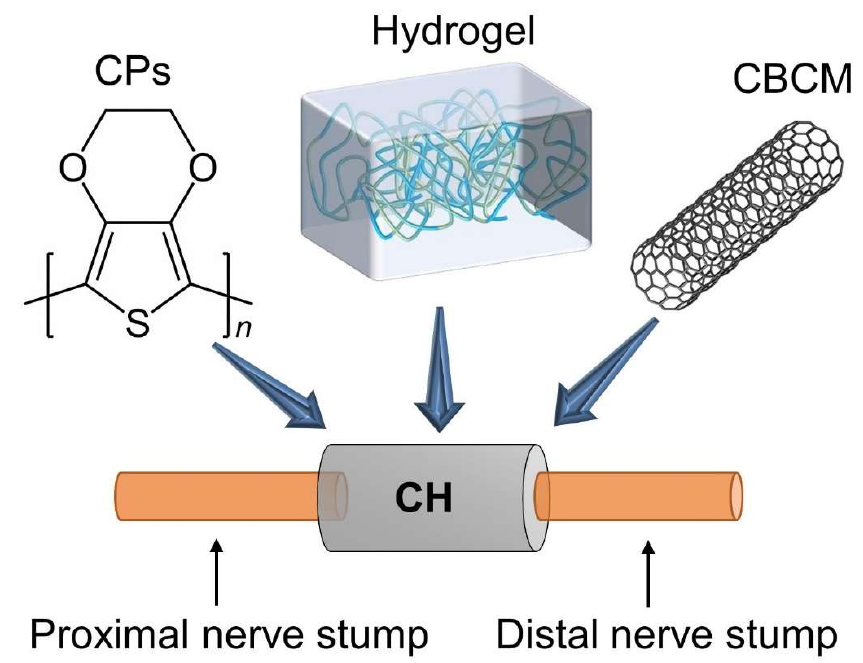
Figure 1. Schematic of conductive hydrogels (CH) for peripheral nerve regeneration. CPs = conductive polymers; CBCM = carbon-based conductive materials; CH = conductive hydrogels.